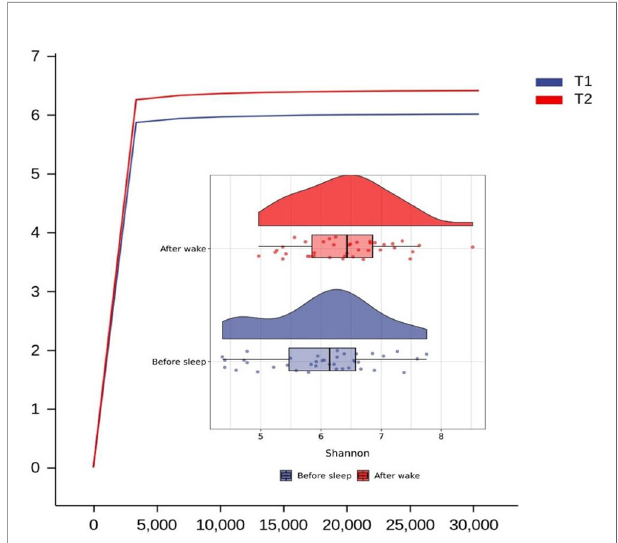
FIGURE 1 | Rarefaction and Raincloud Plot of the tongue coating microbiota before and after sleep and the difference between them in Shannon diversity index (T1 and T2 are the tongue coating microbiota before and after sleep,